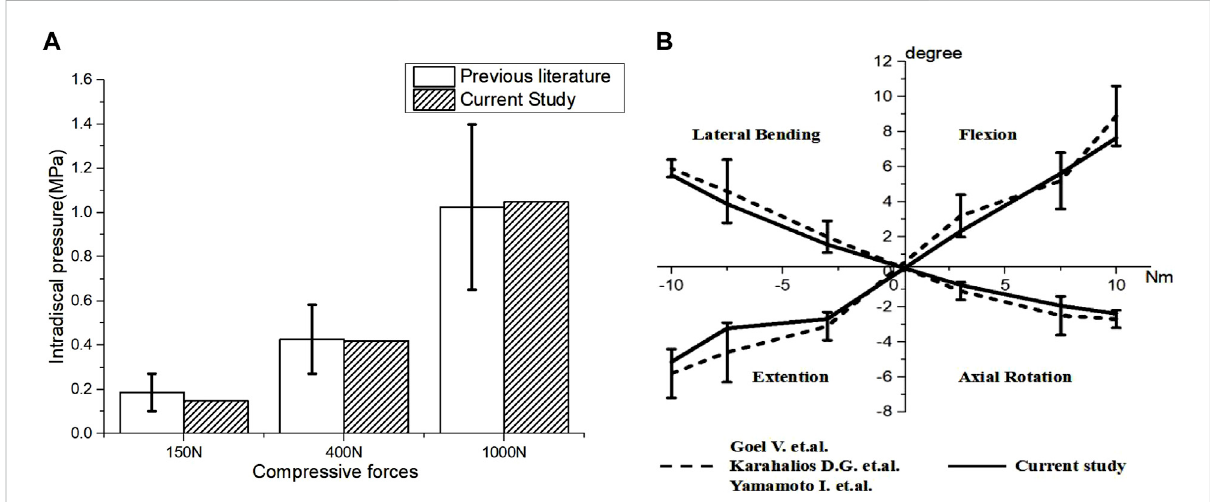
FIGURE 2 Validation of the L4 – L5spinal fi nite element model. (A) Comparison of intervertebral disc stress at theL4 – L5 level and the in vitro experimental data from Dreischarf et al. (2014) and Brinckmann and Grootenboer, 1991, (B) ROM of L4 – L5 lumbar